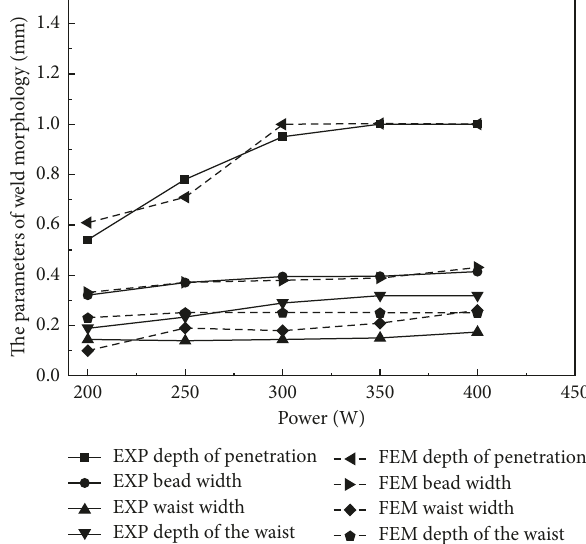
Figure 10: Comparison of experimental and simulation results for the depth of penetration, bead width, waist width, and depth of the waist for different